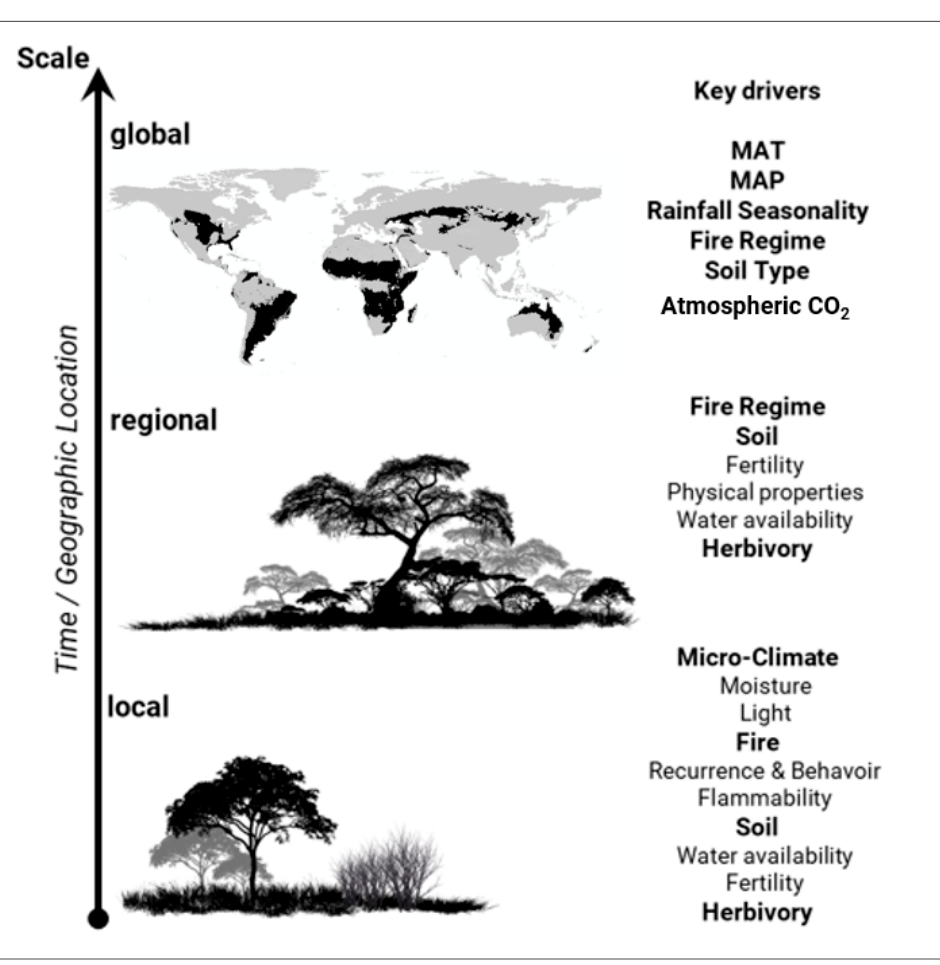
Figure 1. Global, regional, and local factors influencing the tree-grass co-existence and the dynamics of savanna transitional zones of cover types over time. MAT, MAP, and CO 2 represent Mean Annual Temperature, Mean Annual Precipitation, and Carbon dioxide, respectively. The savanna map is based on biome classification according to Hengl et al., 2018. The South American savannas, the Caatinga, and the Cerrado boundaries were updated using the National Institute for Space Research (INPE) products developed by Aguiar et al., 2016. Key drivers are derived from Sankaran et al., 2005, 2008; and Scholes and Archer, 1997.